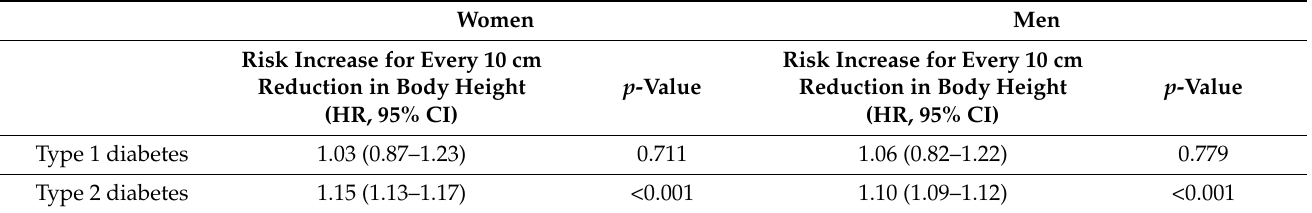
Table 4. Association between adult body height and diabetes by sex (Cox regression